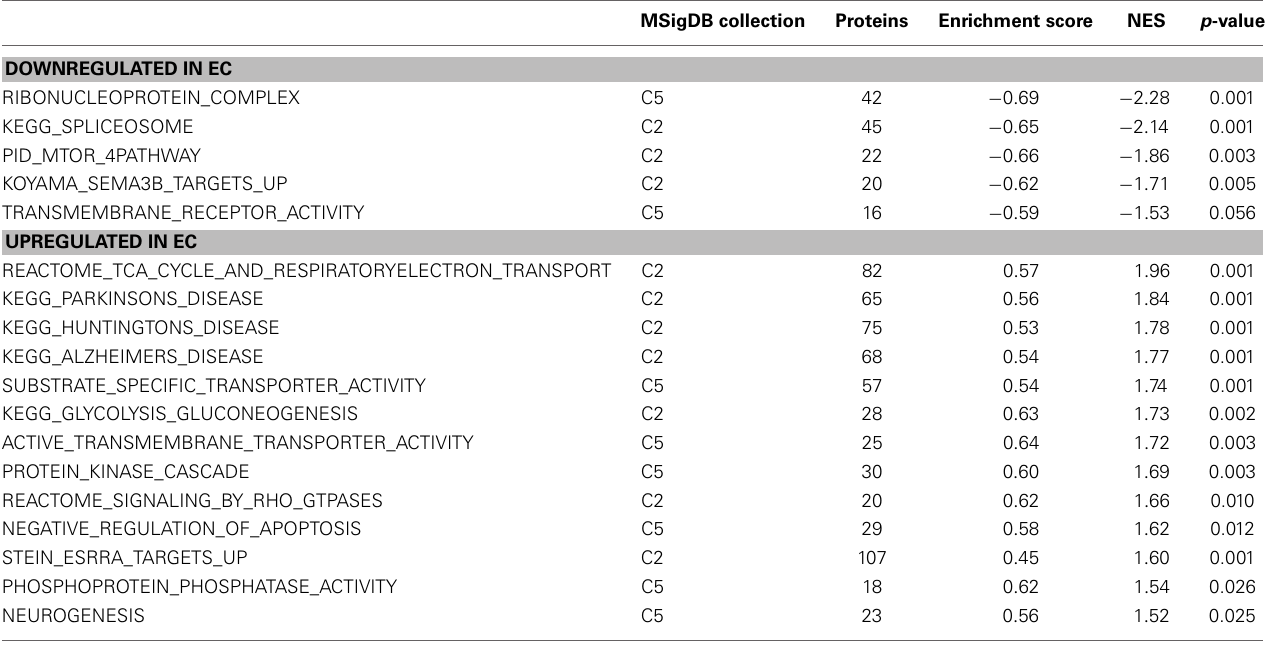
denotes lower. (F) GSEA analysis using Ribonucleoprotein complex GO gene set, showing a decreased expression of proteins relating to splicing the breadth of regulation of different novel pathways and protein sets regulated by enrichment.